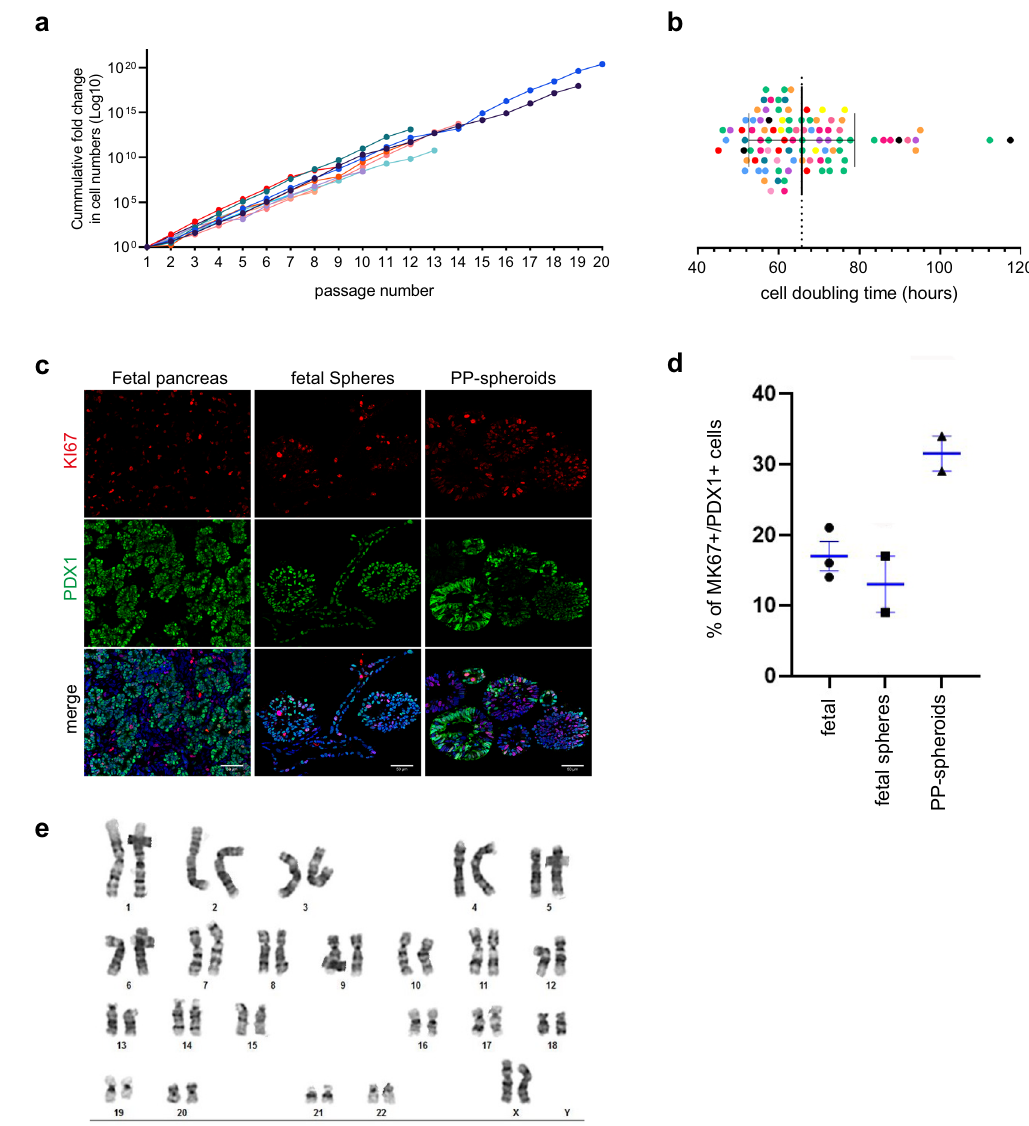
Fig. 4 The conditions used for maintaining PP-spheroids are conducive of physiologically relevant proliferation rates. a Fold-change in cell number. Each line represents PP-spheroids generated independently from hPSC differentiation (H1, H9, HuES4, SBAD3.1, and SBAD3.4). Circles indicate each passaging point. The results are expressed as fold-change relative to the initial cell numbers. b Cell doubling calculated based on cells counted at the time of passaging. Each data point corresponds to a passaging event ( n = 96). Colors represent independent expansion rounds ( N = 11). c Representative tissue sections showing MKI67 and PDX1 in fetal pancreas, fetal spheres, and PP-spheroids. Scale bar = 50 µ m. Images are representative of N = 3 fetal samples, N = 2 fetal spheres, N = 3 PP-sheroids. d The percentage of MKI67 + cells over total number of PDX1 + cells. The samples are fetal pancreas at 7 + 5 wpc, 8 + 4 wpc, and 9 + 6 wpc ( N = 3); fetal spheres at passage 1 and 3 ( N = 2); PP-spheroids at passage 9 and 16 ( N = 2) showing MKI67 and PDX1. Data shown as mean ± SEM. e Karyogram of H9 PP-spheroids at